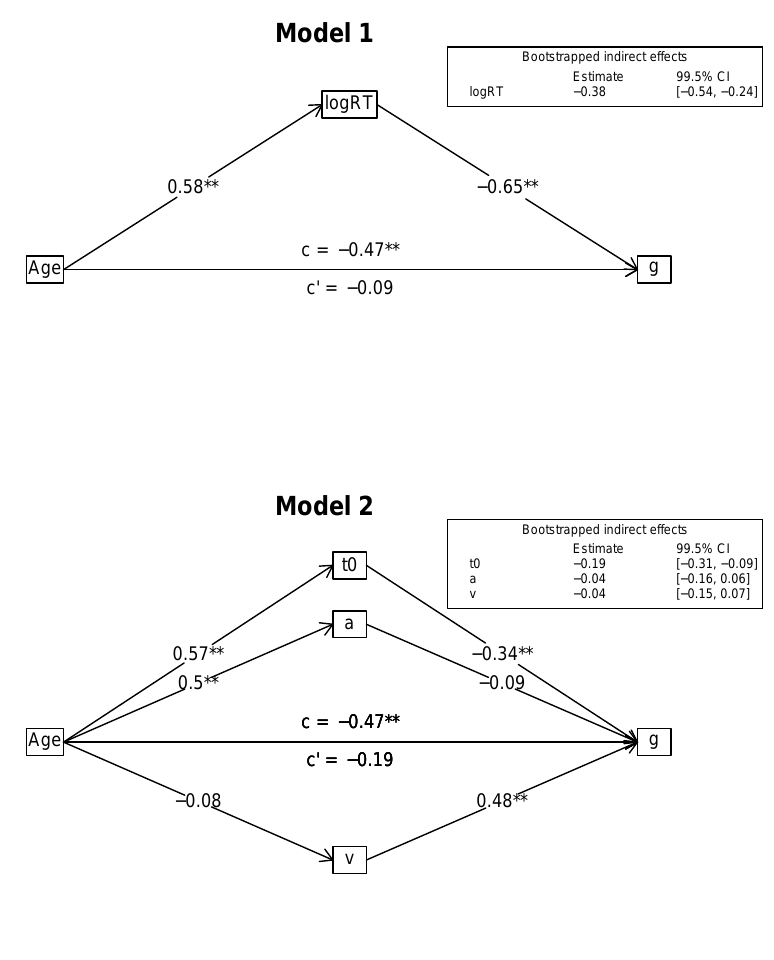
Figure 2. Mediation models for general intelligence. Standardized estimates are reported. ** p <